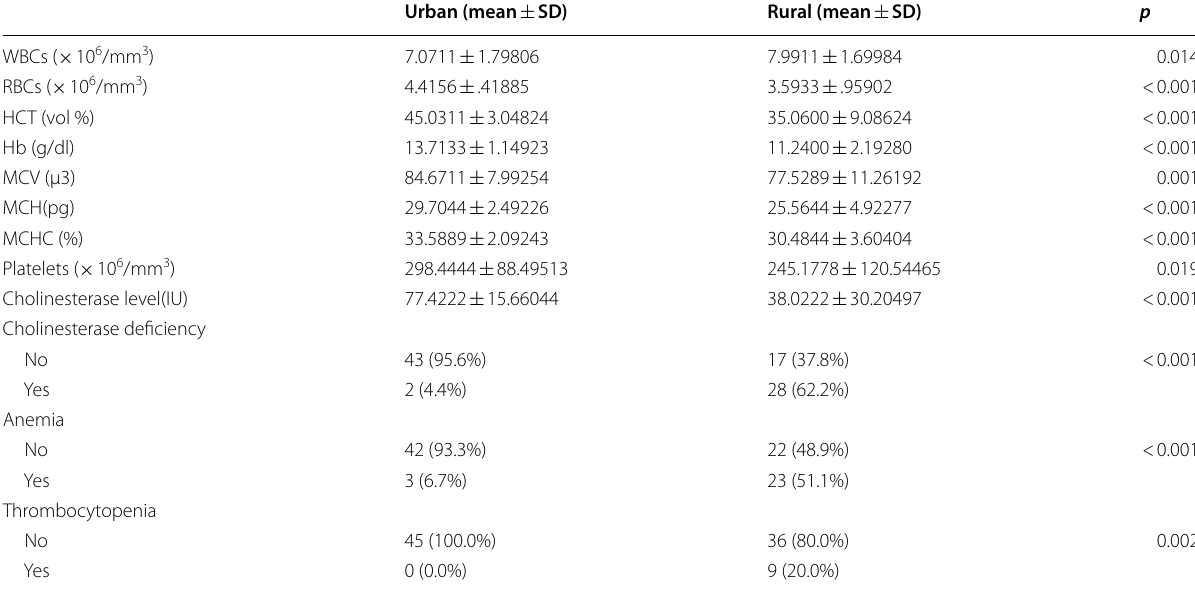
Table 4 Comparison between cases and controls as regarding laboratory